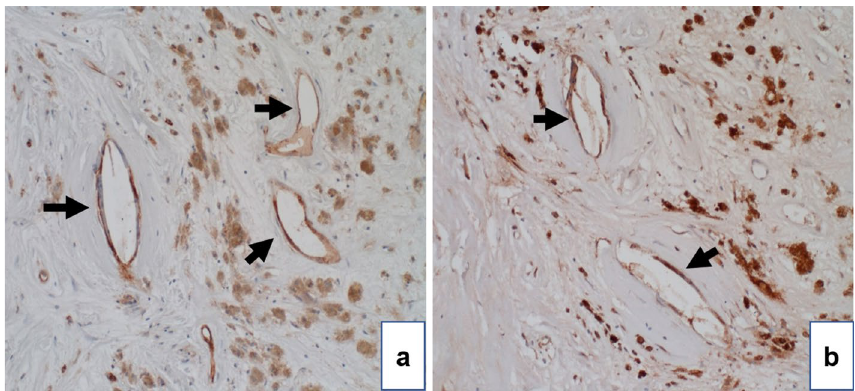
Figure 4. Immunohistochemical staining for SERPINE1 in an arteriosclerotic plaque. Immunohistochemical staining of atherosclerotic plaques samples from nine patients at the Chiba Cerebral and Cardiovascular Center was performed. A representative case is presented here. These samples were obtained from a different cohort than that from which the sera were collected. Atherosclerotic plaque resected during carotid endarterectomy was immunostained using anti-CD31 ( a ) or anti-SERPINE1 antibodies ( b ). Arrows indicate vascular endothelial cells labeled with CD31 antibody, and correspondingly, SERPINE1 was stained by anti-SERPINE1